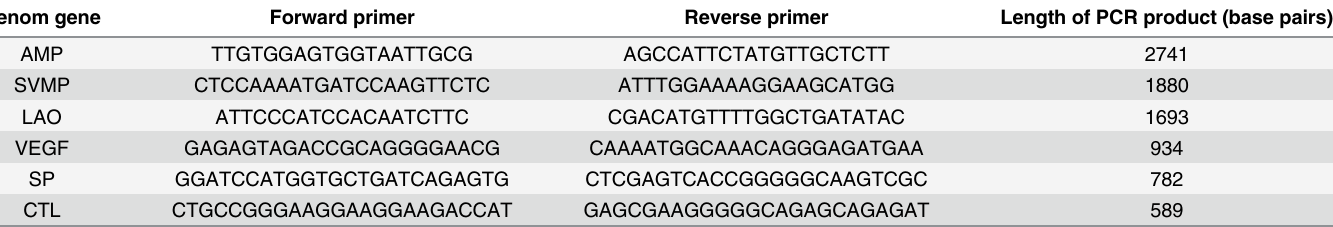
Table 1. Bitis arietans primers.